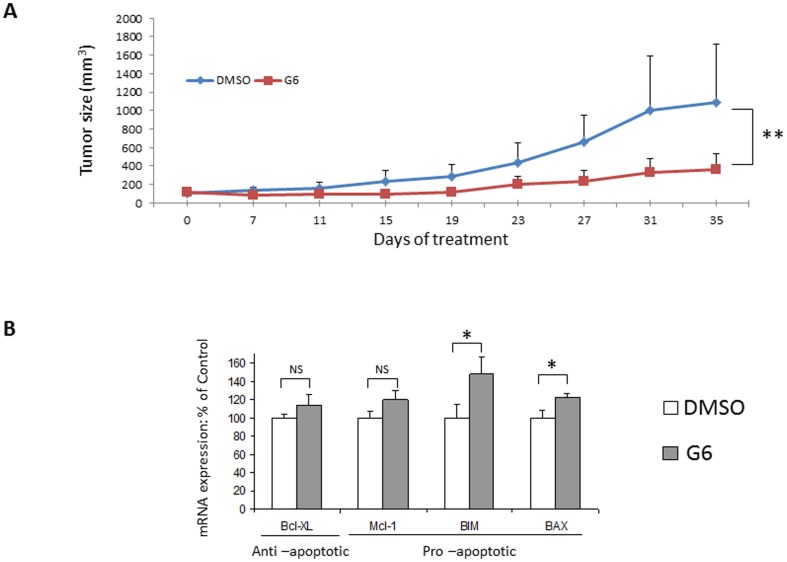
G6 reduces tumor volume in T98G xenografts and this is coincident with increased expression of BIM and BAX.A) After establishment of the tumors, mice began receiving daily injections of either DMSO (n = 4) or 10 mg/kg G6 (n = 5) at Day 0. Tumor volumes are plotted as a function of both treatment condition and time. B) Average mRNA levels of various apoptotic markers taken from the tumors. *, p<0.05, **, p<0.01.